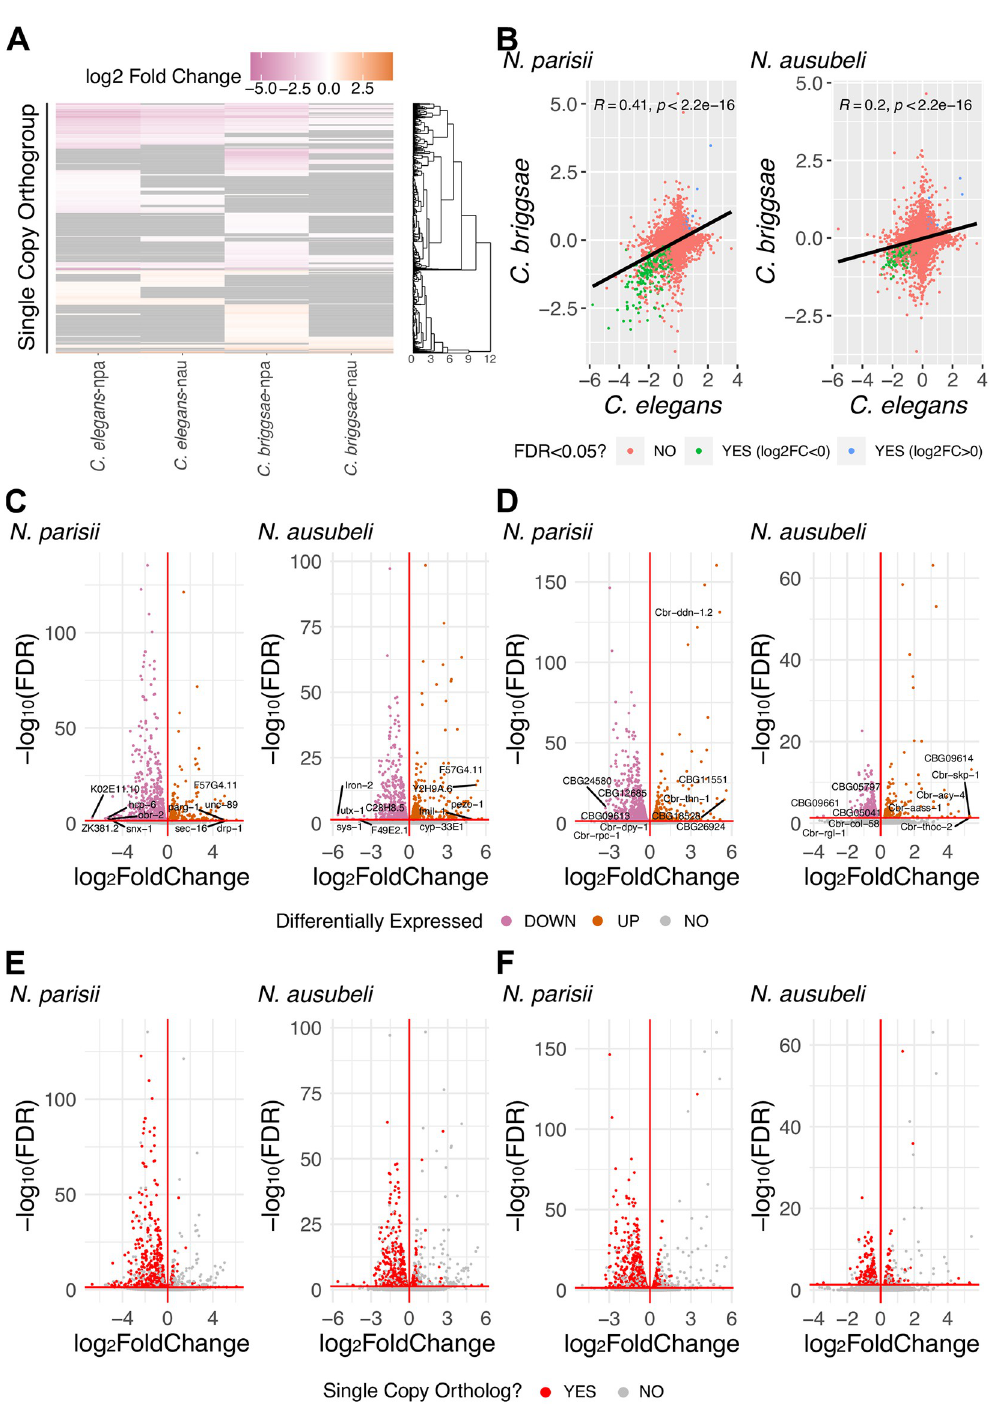
Fig 6. Transcriptional responses of single copy orthologs in Caenorhabditis hosts to Nematocida infection. (A) Heatmap of transcriptional profiles of single-copy orthologs in C . elegans and C . briggsae after infection by N . parisii or N . ausubeli . Rows represent genes clustered hierarchically. Scale is of differential regulation of infected compared to uninfected samples. (B) Scatterplot of log2 fold change values of single-copy orthologs expressed in C . elegans and C . briggsae . Each point represents a single-copy ortholog between the two host species. Pearson correlation values and p-values are indicated on top left of each plot. The ratio of log2 fold change values for each single copy ortholog between C . elegans and C . briggsae is demonstrated by the colour of the points. (C-D) Volcano plots of genes expressed in Nematocida infected C . elegans (C) and C . briggsae (D). Upregulated genes are represented with orange points; downregulated genes are represented with